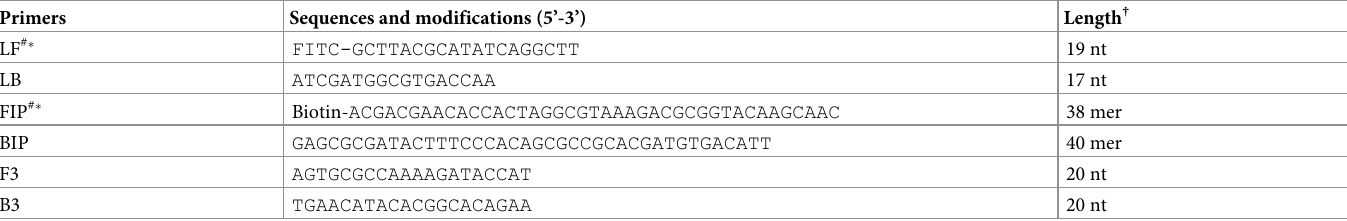
Table 2. Primers used in the LAMP assay to identify the mcr-1